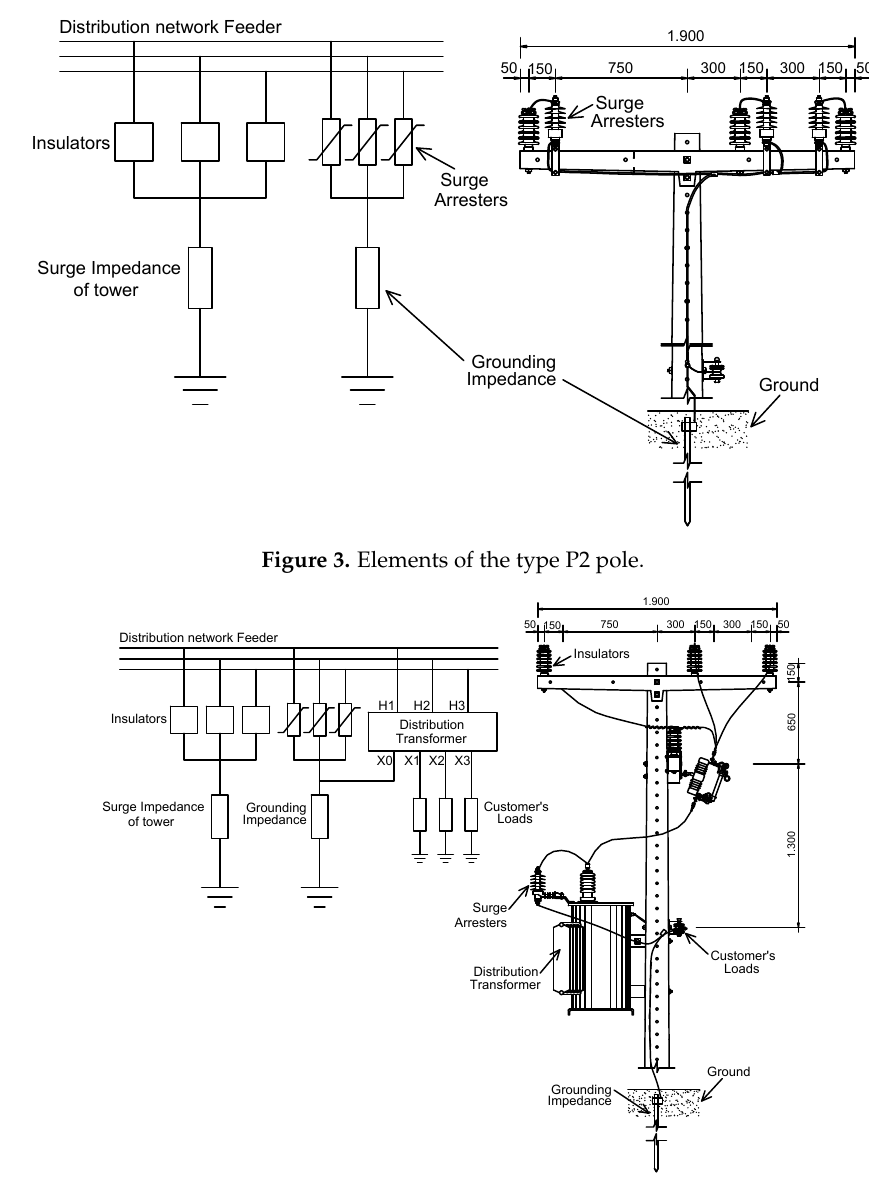
Figure 4. Elements of the type P3